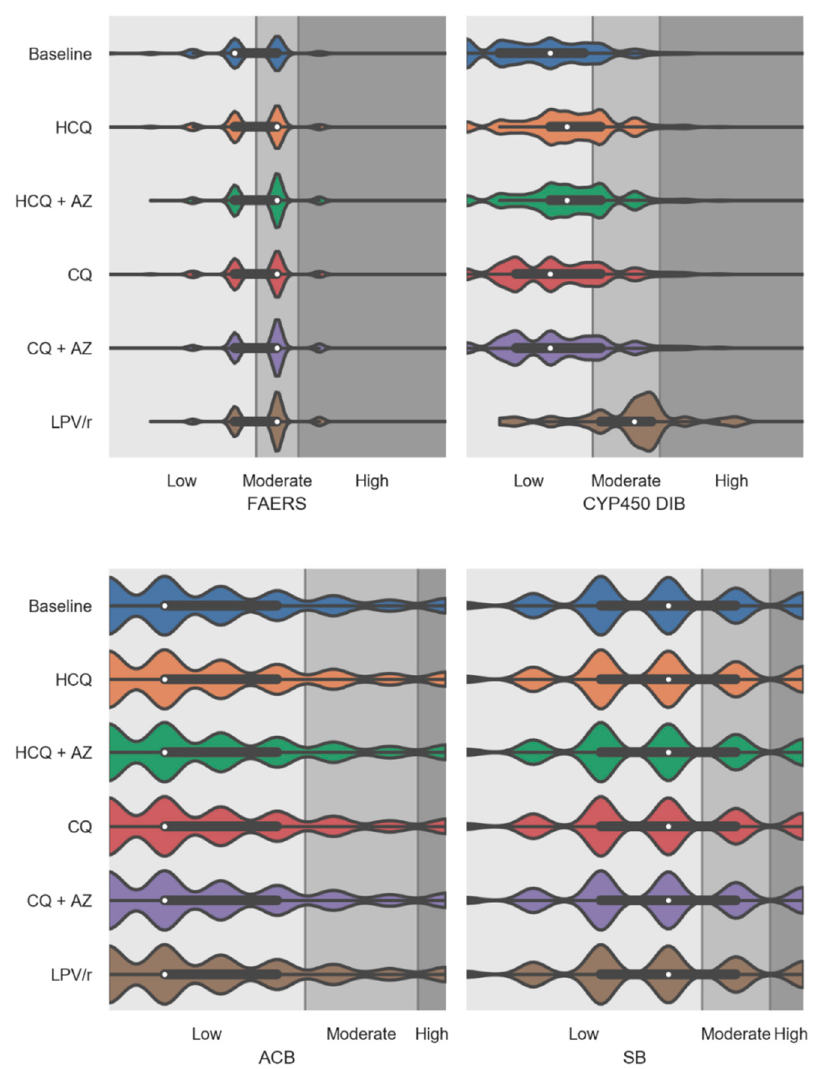
Figure 3. Violin plots showing the medication risk scores for individual factors including FDA Adverse Event Reporting System (FAERS), CYP450 drug interaction burden, anticholinergic burden, and sedative burden scores at baseline and after the virtual addition of repurposed drugs into PACE participants’ drug regimens. The white dots are the medians, and the colored areas are probability density estimates. Abbreviations: HCQ, hydroxychloroquine; AZ, azithromycin; CQ, chloroquine; and LPV/r, lopinavir + ritonavir.